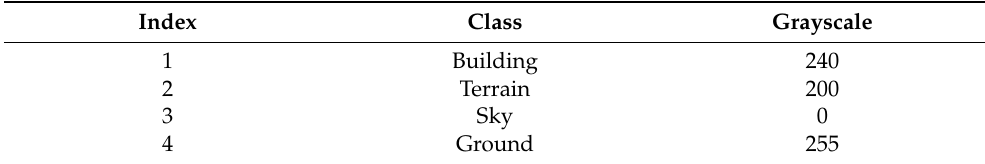
Table 1. Grayscale value of class in